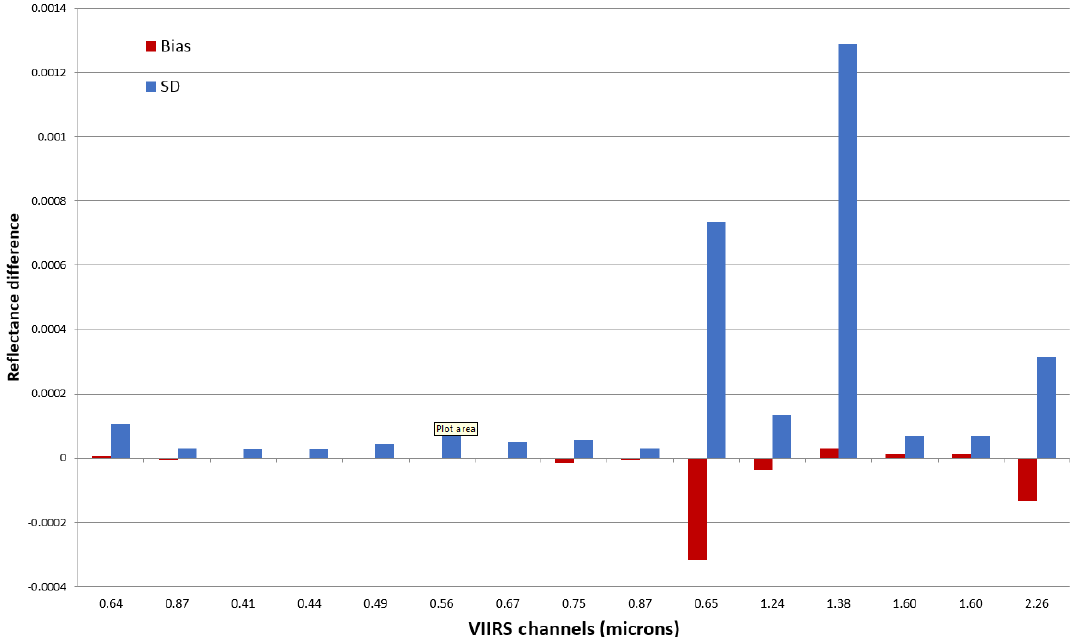
Figure 4. The mean difference for VIIRS visible/near IR channels between the HITRAN line-by-line model and RTTOVv12 for the 83-profile set for all clear-sky views with zenith angles up to 84 ◦ using version 9 predictors.